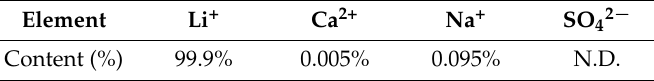
Table 4. The element content of the lithium carbonate after the hydrogenation–decomposition and the ion-exchange.